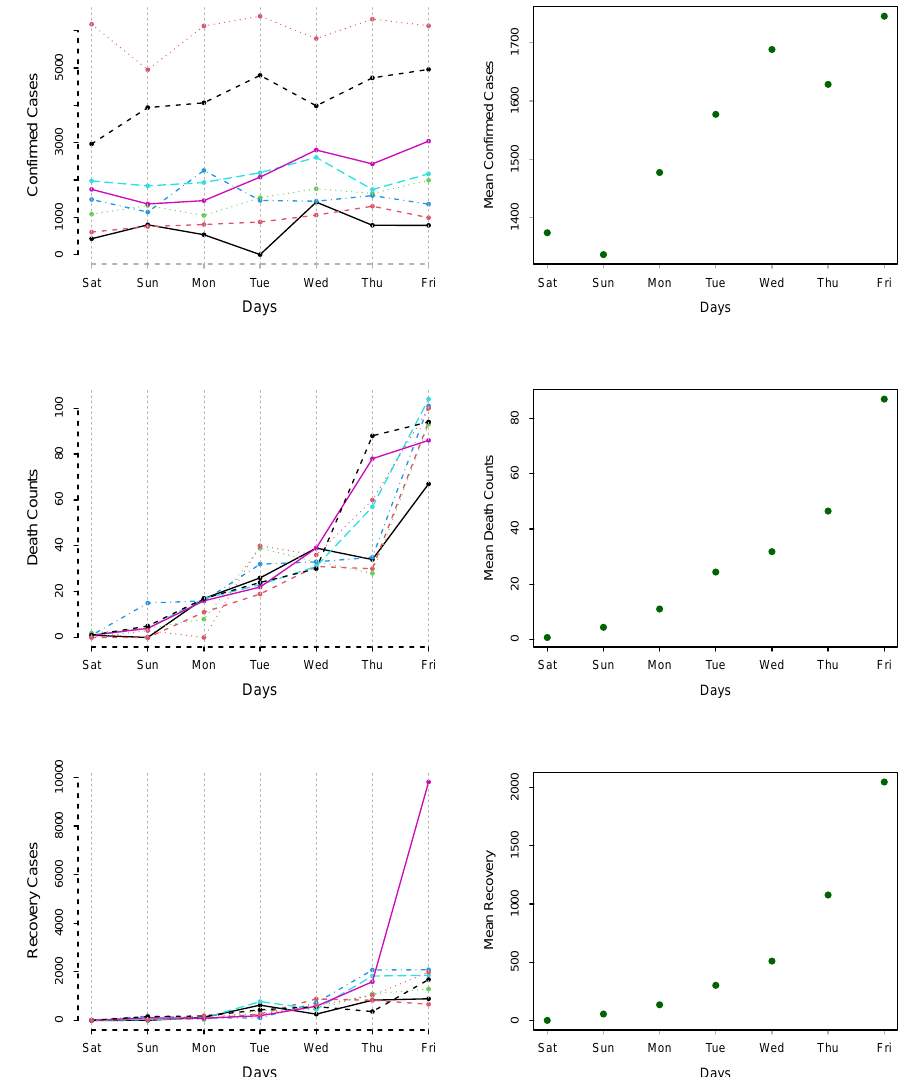
Figure 6. Weekly COVID-19 cases: day-specific confirmed cases, deaths, and recovered cases; ( left column ) and mean day-specific ( right column ) for the period of 21 March to 19 June